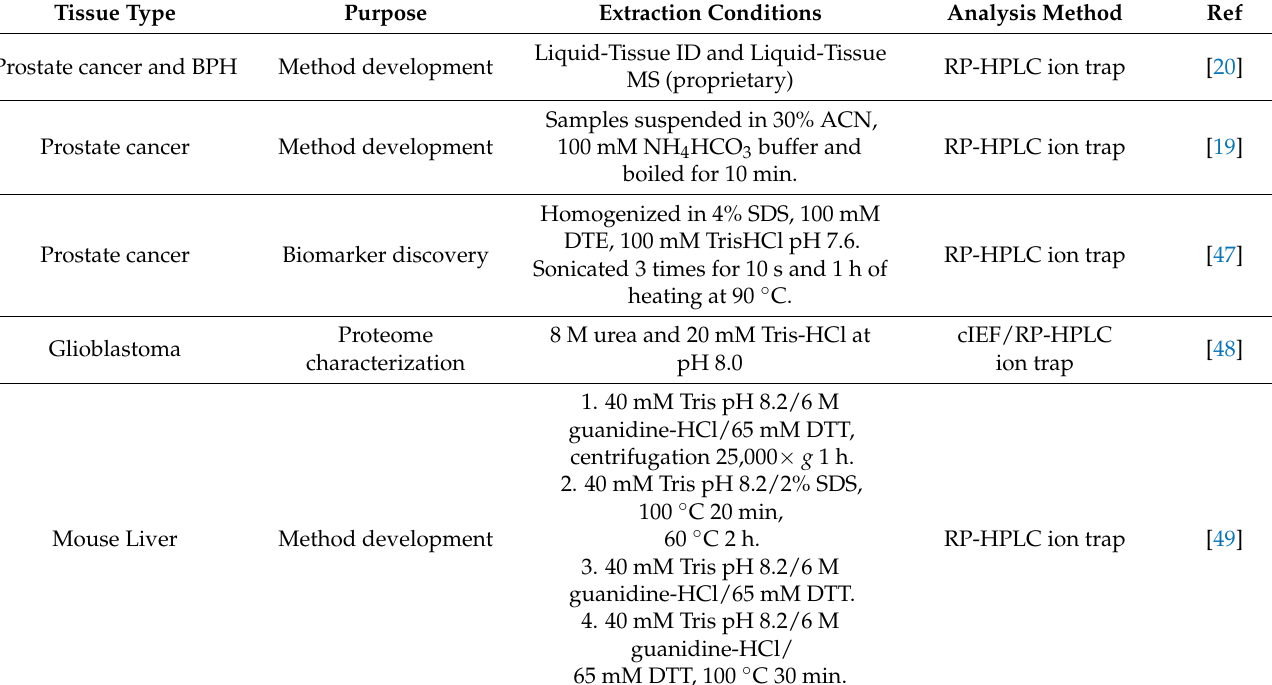
Table 2. Partial list of studies that have analyzed formalin-fixed paraffin-embedded (FFPE) tissues along with tissue type, purpose of study, extraction conditions, and analysis method.